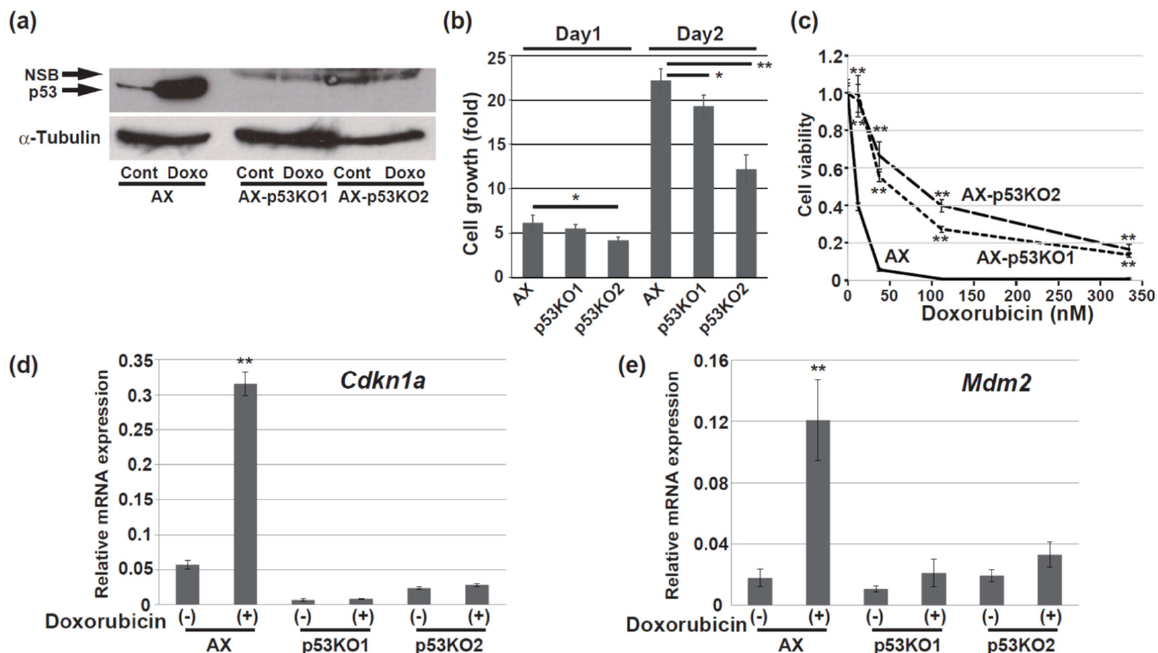
Figure 2. The R270C mutant does not block the function of wild-type p53. ( a ) Immunoblot analysis of p53 expression using an antibody (#ab90363) in the AX and p53-knockout AX cells with or without 0.5 µ M doxorubicin for 16 h. KO, knockout; NSB, nonspecific bands; Doxo, doxorubicin. ( b ) The growth of the AX and p53-knockout AX cells. The ratio relative to the value for day 0 was calculated for each datapoint. ( c ) The viability of the AX and p53-knockout AX cells was assessed after 2-day exposure to the indicated concentrations of doxorubicin. The statistical significance between AX cells and the respective knockout cells is shown. ( d , e ) RT and real-time PCR analysis of Cdkn1a ( d ) and Mdm2 ( e ) mRNA in the AX and p53-knockout AX cells treated with or without 0.5 µ M doxorubicin for 16 h. The data are normalized to the corresponding levels of Actb mRNA and are shown as the means ± SD of triplicate values. (* p < 0.05; ** p <